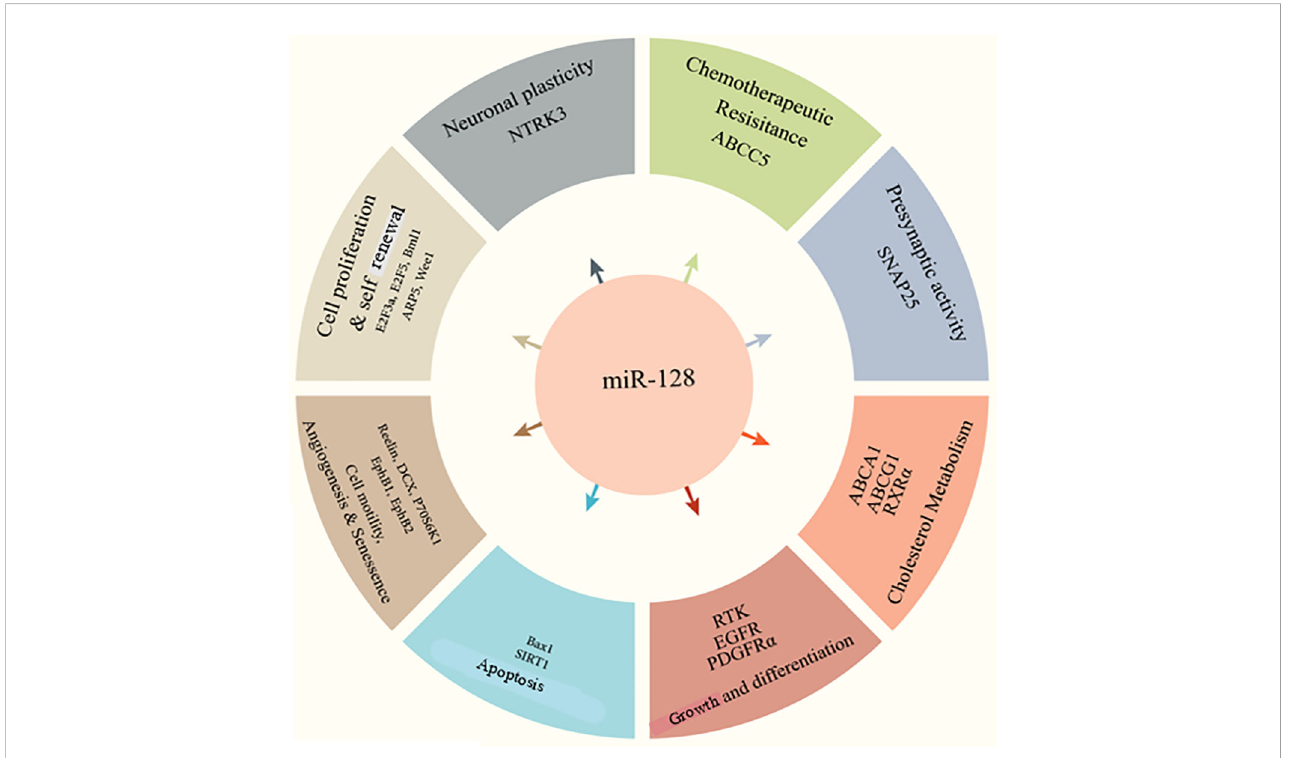
FIGURE 1 miR-128 functions in the different cellular